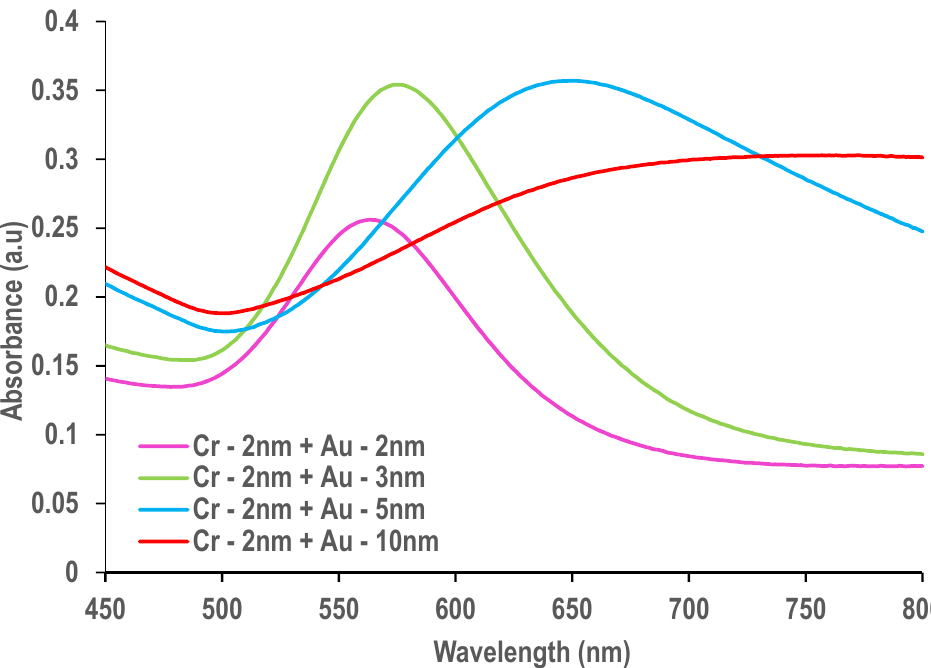
Figure 2. Visible spectra of e-beam evaporated gold films, annealed at 500 ◦ C for 2 h with di ff erent nominative film thicknesses of gold (Au) with a 2 nm chromium (Cr)